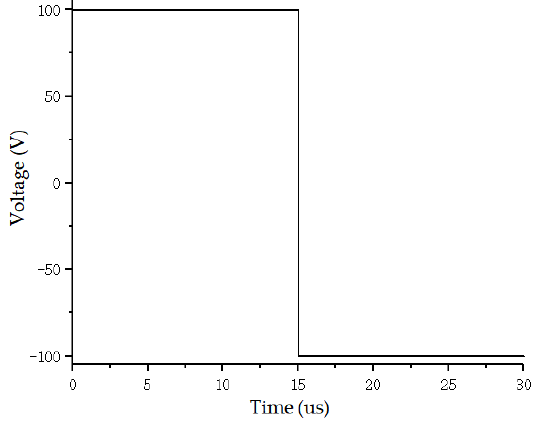
Figure 6. Signal applied to actuator.